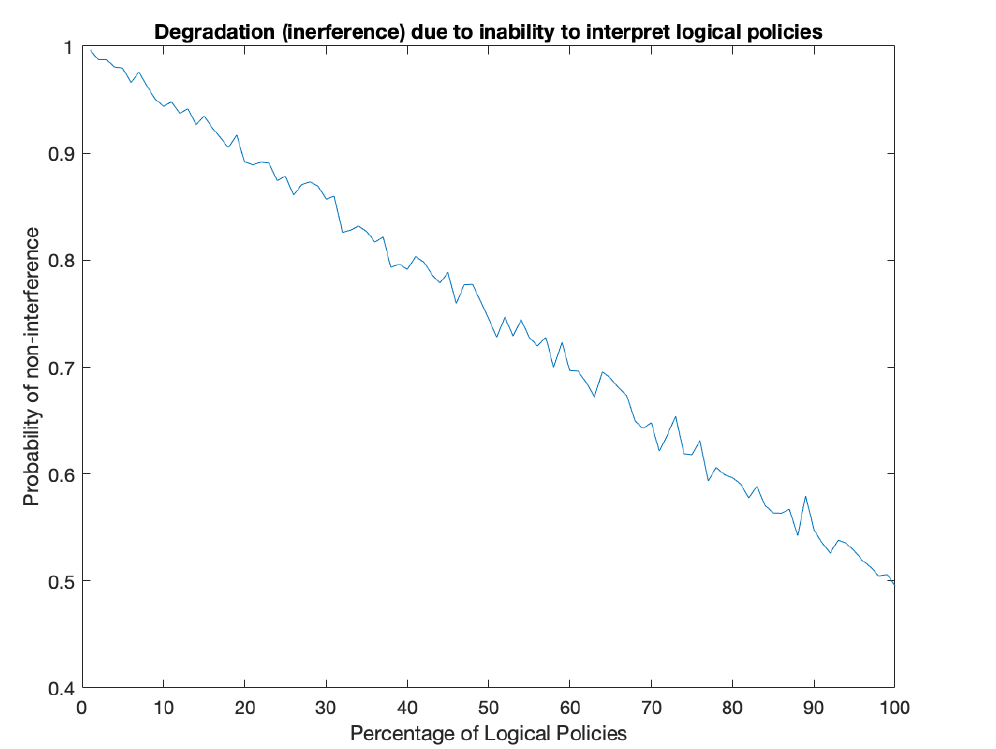
Figure 12. The impact of the missing capabilities on interpreting higher-level policies: simulation